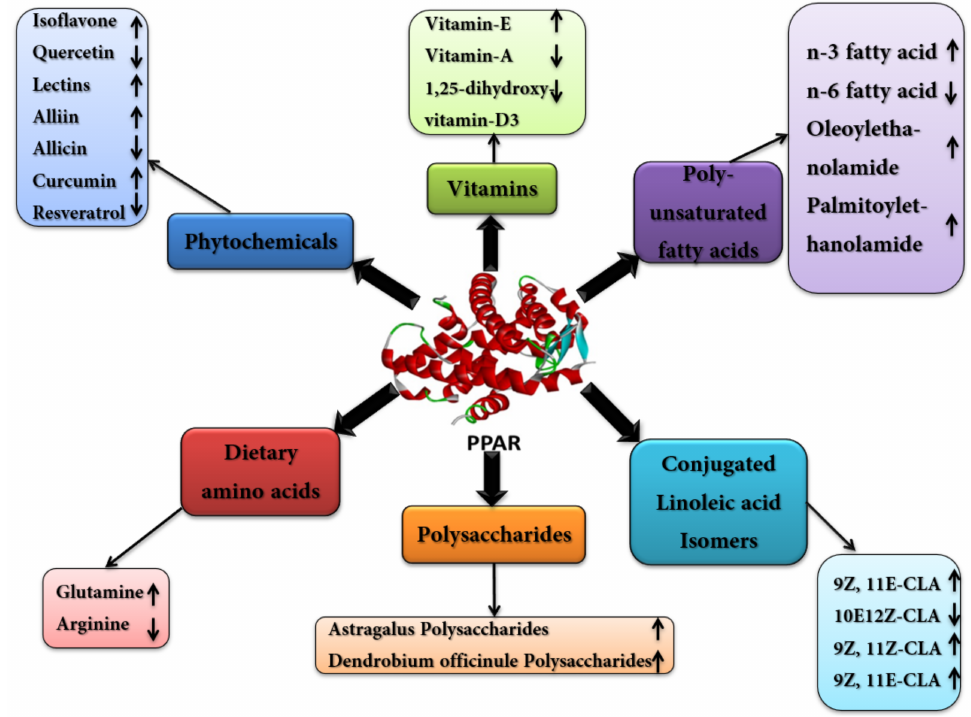
Figure 3. The effect of different nutrients on PPAR. Different nutrients regulate PPAR either by its upregulation or downregulation. The arrow up shows the upregulation of PPAR, while the arrow down shows the downregulation by respective